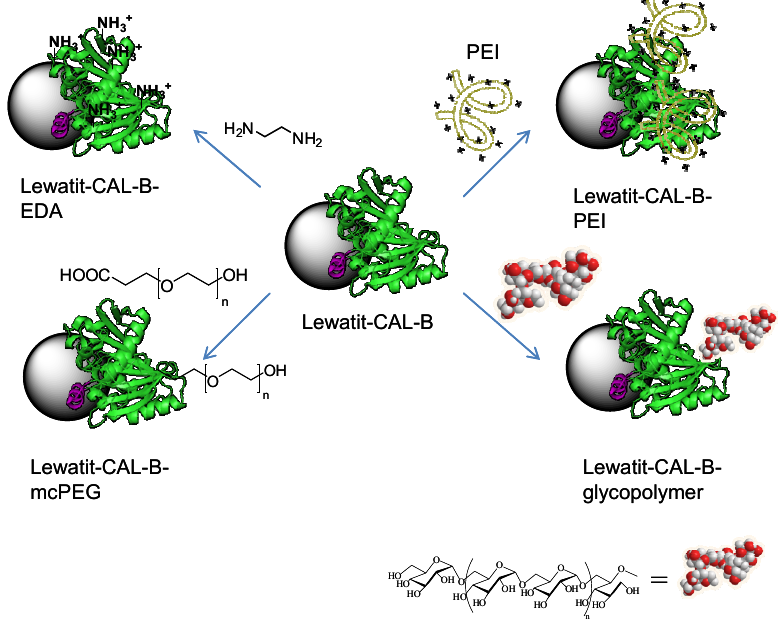
Figure 2. Different chemical modification of Lewatit-CAL-B on the solid phase.